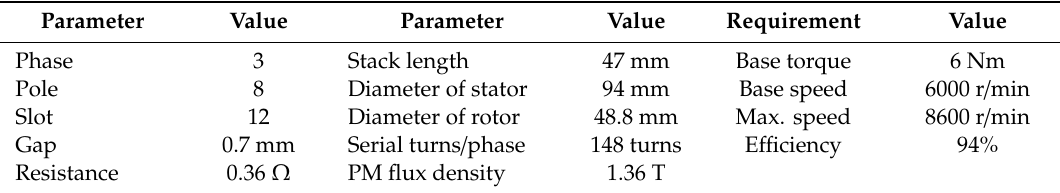
Table 1. Specification of stator and rotor and requirements.